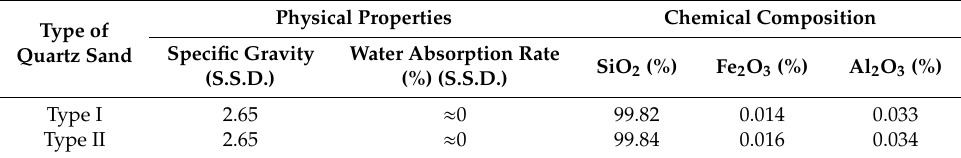
Table 1. Physical properties and chemical composition of fine aggregates.